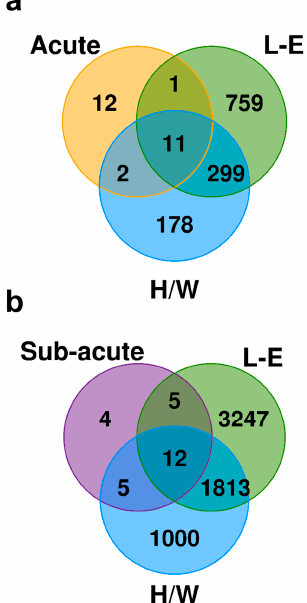
Figure 4. Transcriptomic impact of C2 differs from that of TCDD. Venn diagrams display the number of genes which had significantly different mRNA abundance following ( a ) acute exposure to C2 (Sprague-Dawley rats) and TCDD (H/W or L-E rats) or ( b ) subacute exposure to C2 (repeated dosing) and TCDD (single dose). Only genes with mRNA abundance measured in both studies were considered ( n = 9534).